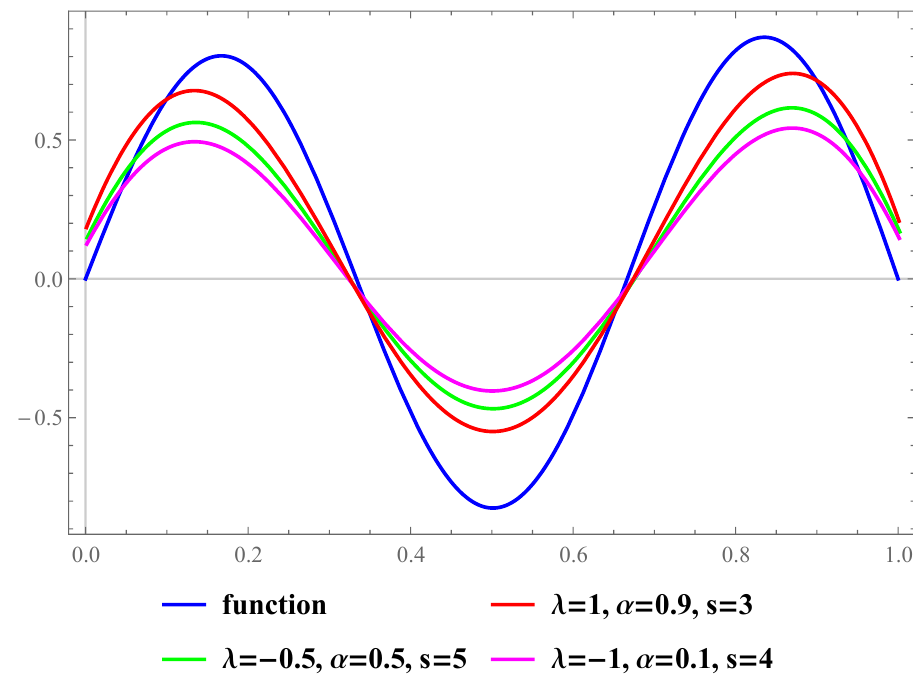
( α , s ) for function r 3 ( u ) p , λ